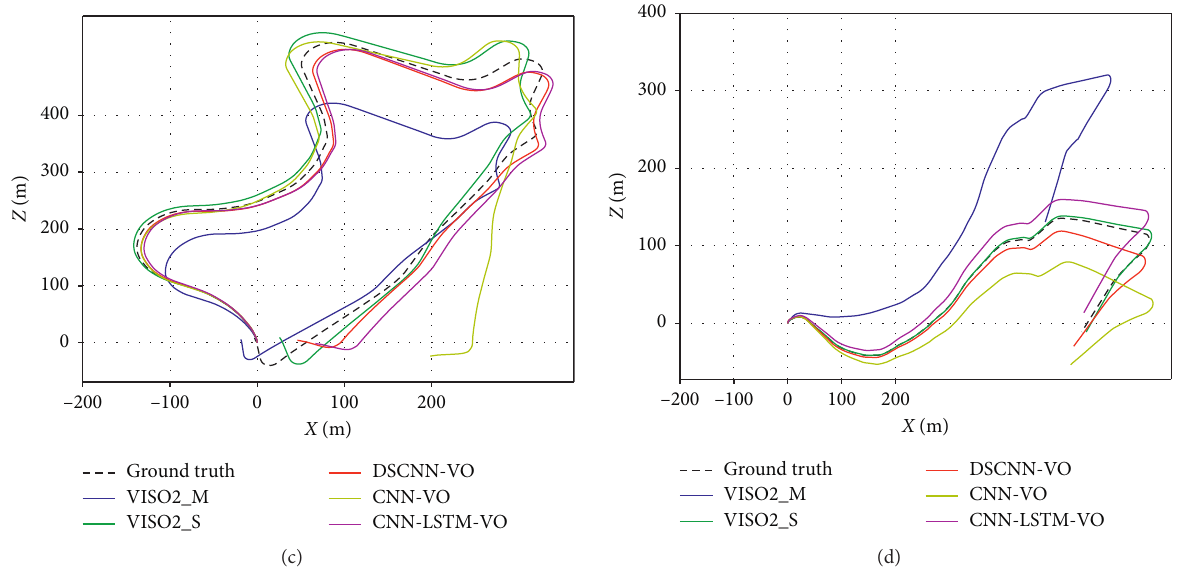
Figure 7: The quantitative experiment. Trajectories of results of the DSCNN-VO for quantitative analysis on (a) Sequence 04, (b) Sequence 05, (c) Sequence 09, and (d) Sequence